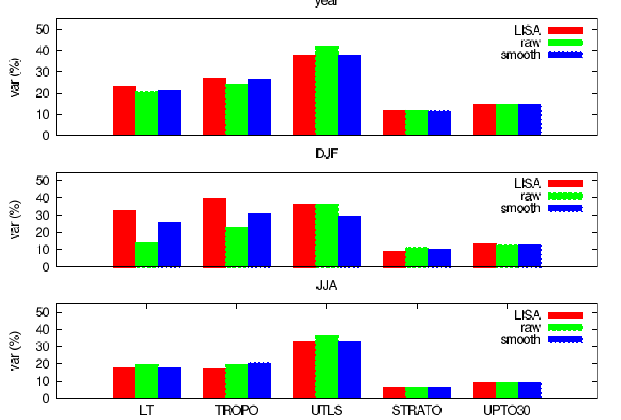
Fig. 10. Seasonal variation in the northern midlatitudes of bias (bot- tom panel), rms (middle panel) and correlation coefficient ( r , top panel) for the comparison of the LA retrieved partial columns and the smoothed ozonesonde partial columns. The definition of the partial columns is given in Sect.